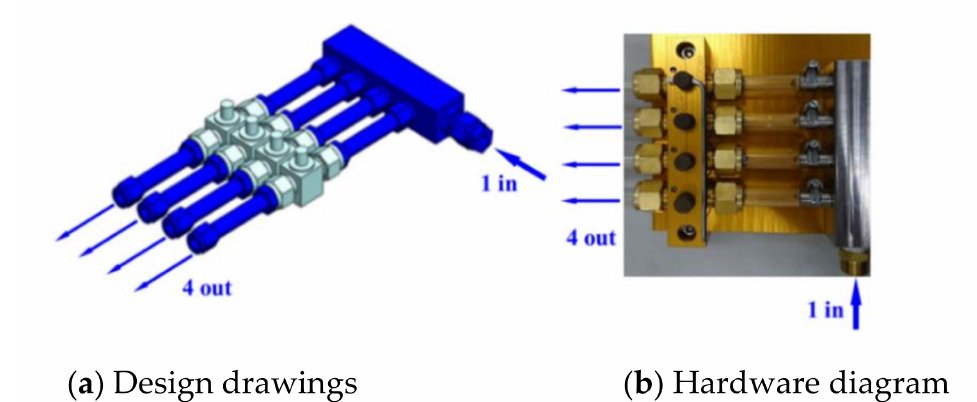
Figure 13. Shunt